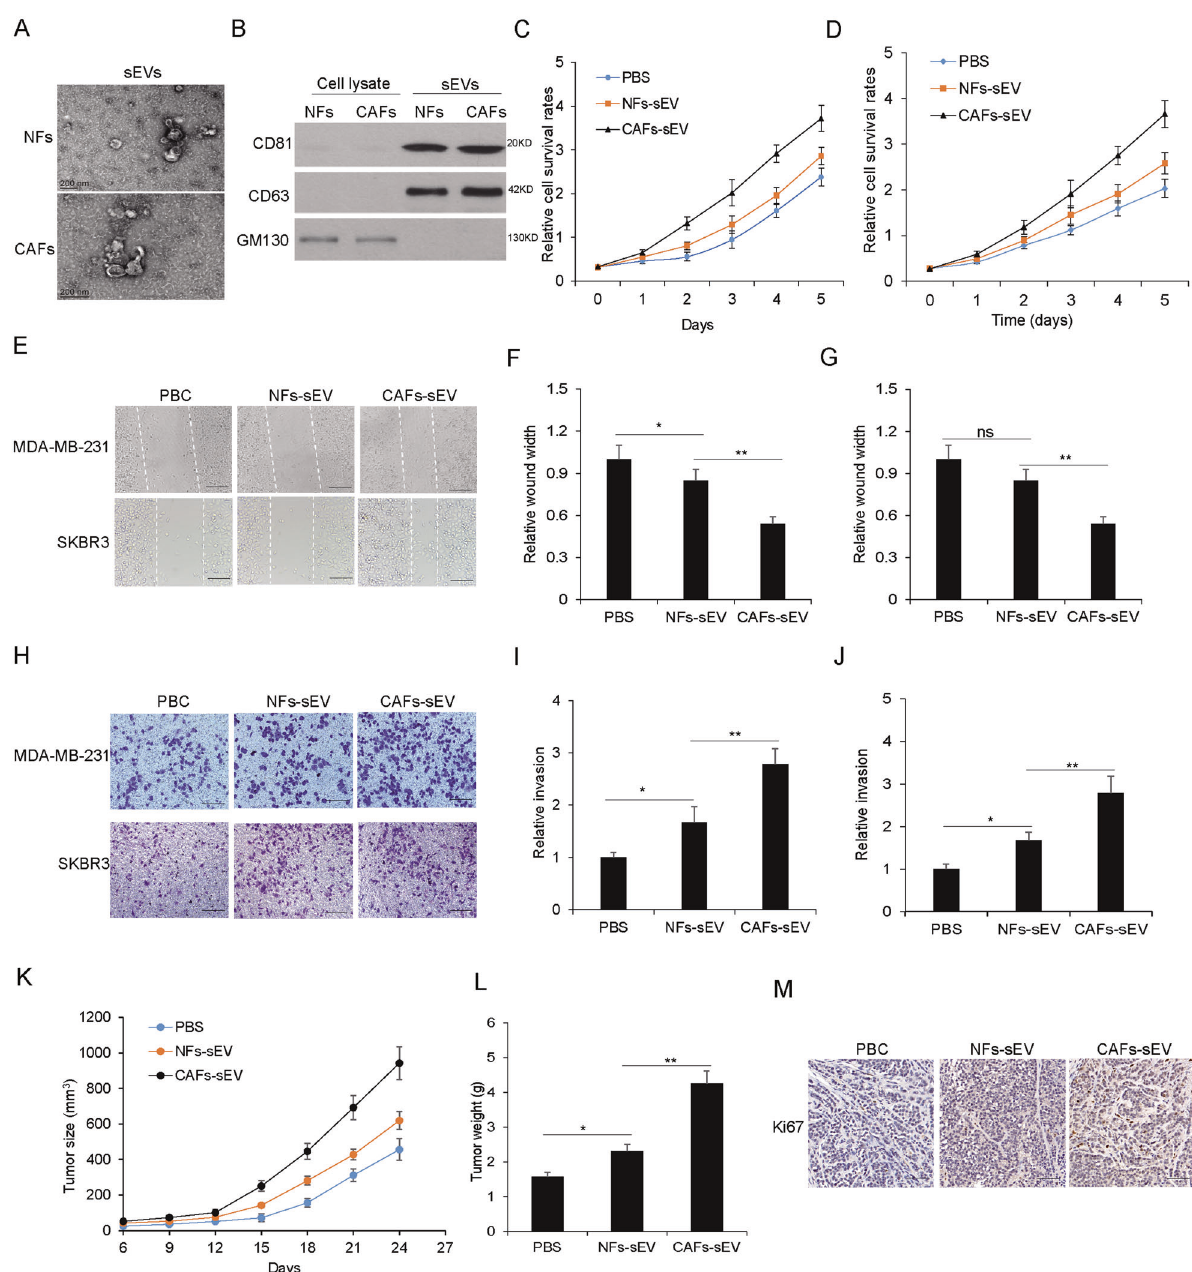
Fig. 1 The sEVs from CAFs increased breast cancer cell survival and metastasis ability. A The representative picture of sEVs from NFs or CAFs. Transmission electron microscopy was used to take the pictures. B The sEVs markers were identi fi ed. The total protein was isolated from NFs or CAFs derived sEVs and performed for CD81, CD63, and GM130 immunoblotting by western blotting. C , D Cell proliferation of MDA-MB- 231 and SKBR3 cells exposed to CAFs-sEV and NFs-sEV (25 µg/ml) assayed by CCK8. E Wound healing assay was used to examine cell migration of MDA-MB-231 and SKBR3 cells with CAFs-sEV or NFs-sEV treatment (25ug/ml) (scale bars, 100 µm). F , G Data analysis of ( E ). H Transwell system was used to examine cell invasion of MDA-MB-231 and SKBR3 cells with CAFs-sEV or NFs-sEV treatment (25 µg/ml) (scale bars, 100 µm). I , J Data analysis of ( H ). K Tumor growth in vivo. l the average tumor weight. M IHC straining for Ki67 (scale bars, 50 µm). * p < 0.05, ** p <